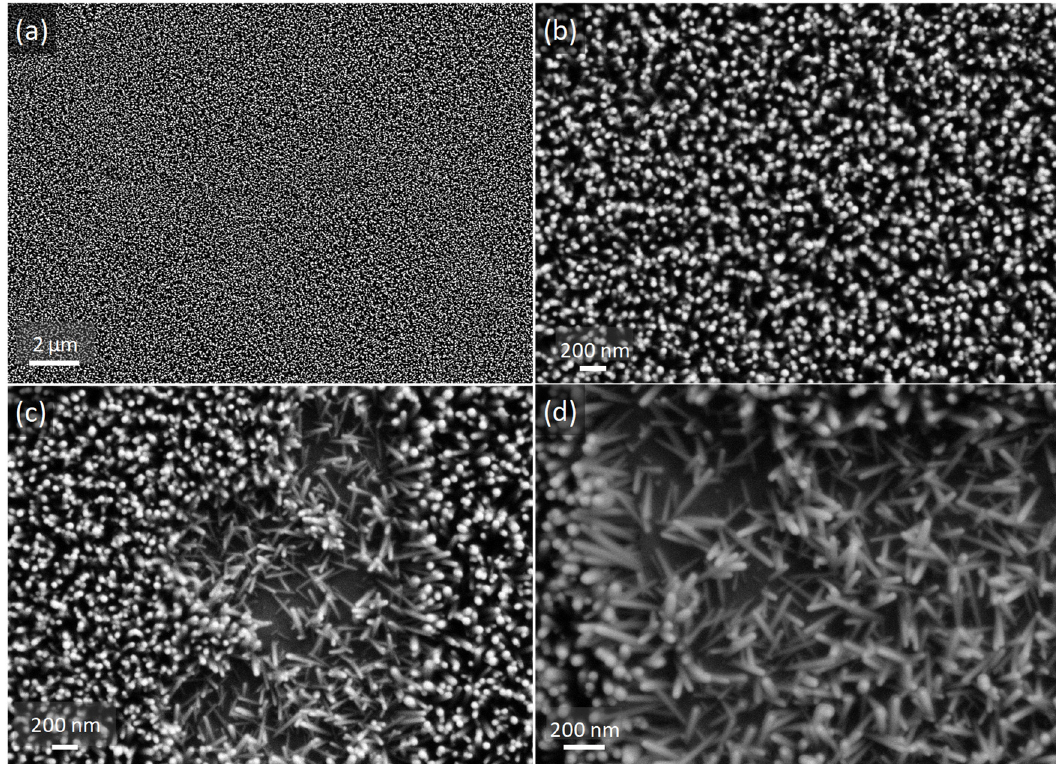
Figure 3. SEM images of YAG:Ce coating covered by ZnO NWs at different magnifications: ( a ) ×5000, ( b ) and ( c ) ×25,000 and ( d ): ×40,000. Image ( c ) and its zoom in ( d ) were recorded in one of the ( b , c ) × 25,000 and ( d ): × 40,000. Image ( c ) and its zoom in ( d ) were recorded in one of the rare places rare places where NWs had collapsed and hence are well distinguished. where NWs had collapsed and hence are well